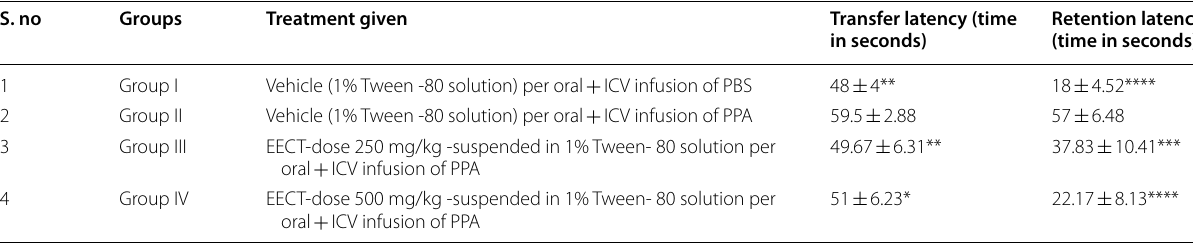
Values are represented in Mean Comparison: Group II vs Group I, Group II vs Group III, and Group II vs Group